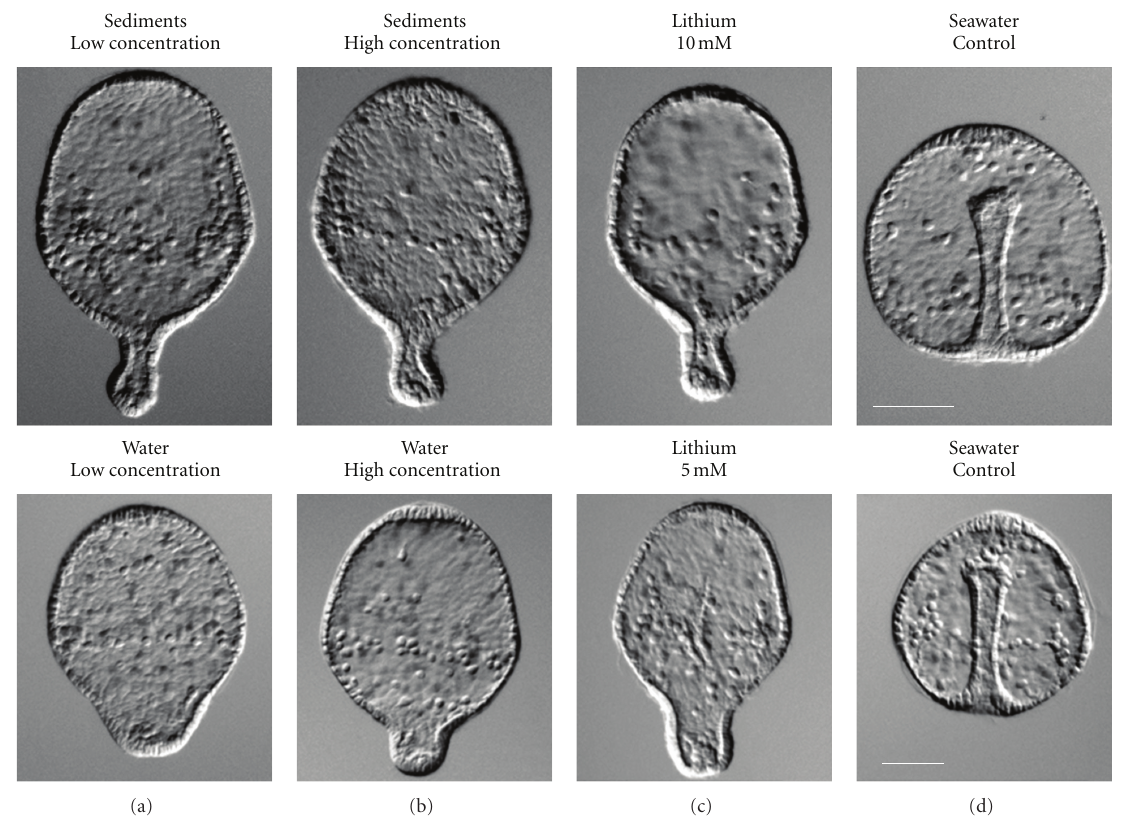
Figure 4: Deformities and abnormalities (exogastrulation) observed in fish embryos exposed to water and sediment extracts from Estero de Urias.